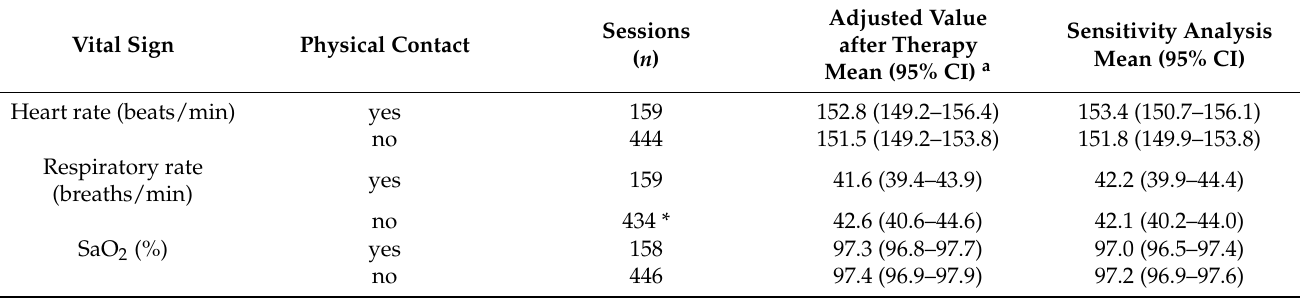
Table 3. Adjusted heart rate, respiratory rate and oxygen saturation before and after music therapy sessions with and without physical contact to